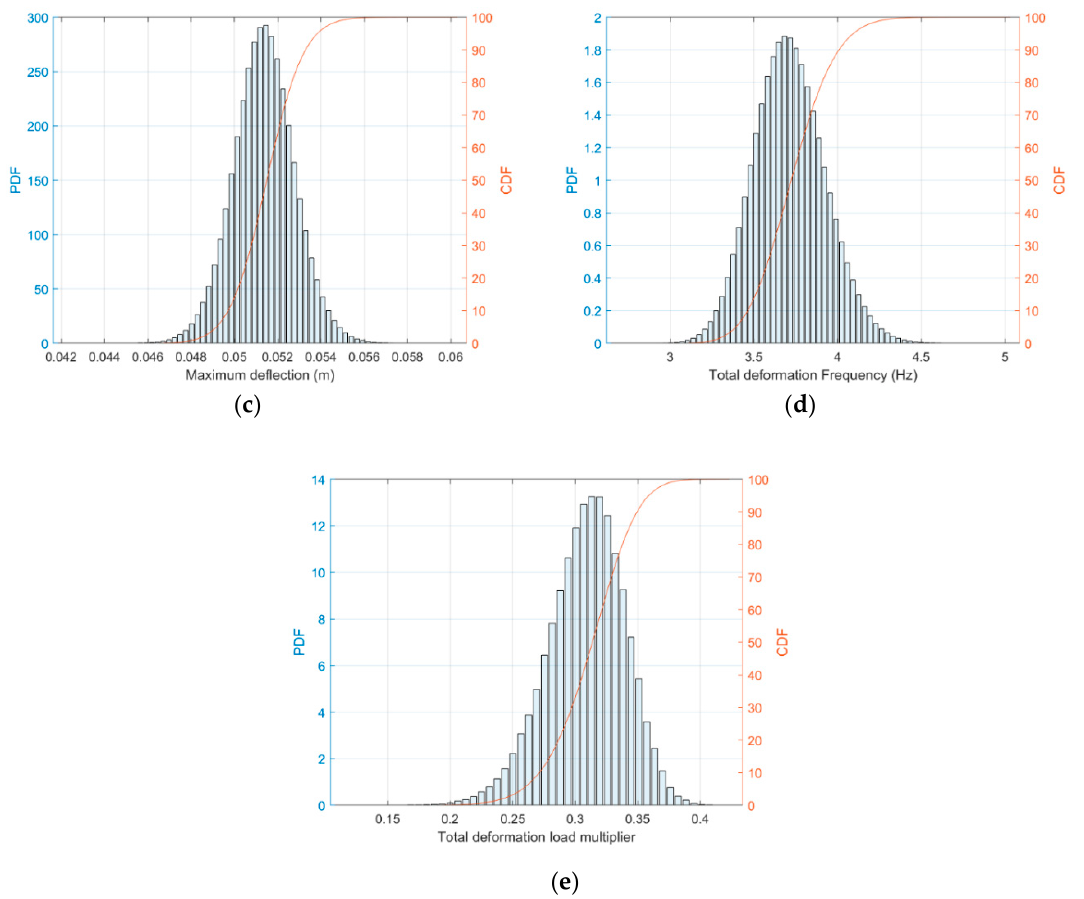
Figure 8. Cumulative density function (CDF) and histogram for the output parameter: ( a ) maximum von Mises stress (stress constraint case); ( b ) fatigue safety factor minimum (fatigue constraint case); ( c ) maximum deformation; ( d ) total deformation load multiplier (buckling constraint case);, ( e ) first eigen-frequency (vibration constraint case)-DesignXplorer©.